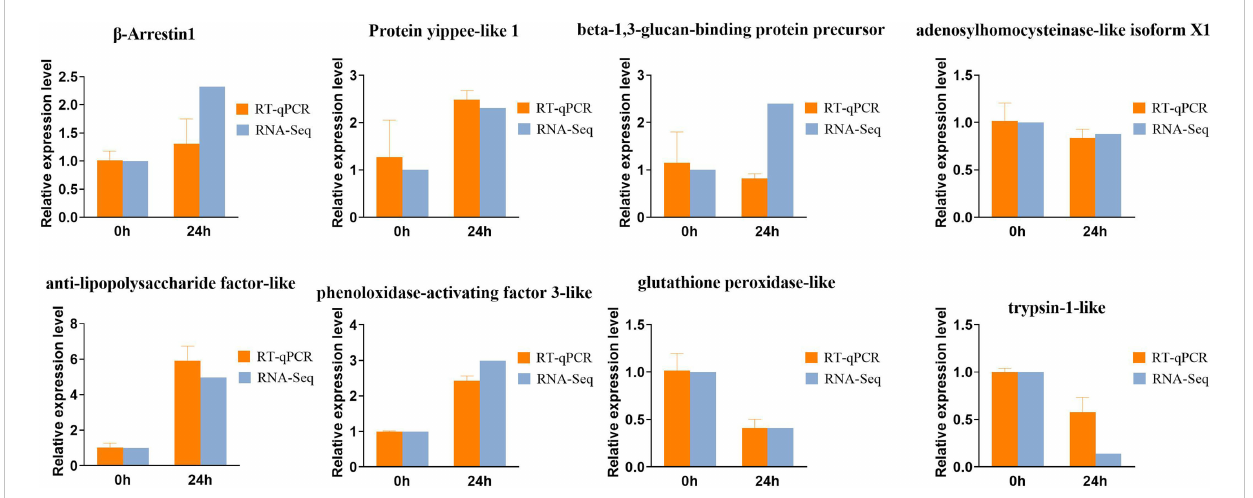
FIGURE 5 Transcripts from RNAseq data were veri fi ed by quantitative real-time PCR (qPCR), where the genes associated on Zoea larvae were beta-Arrestin1, Protein yippee-like 1, beta-1, 3-glucan-binding protein precursor, adenosine homocysteinase-like isoform X1, and on adults were anti- lipopolysaccharide factor-like, phenol oxidase activator 3-like, glutathione peroxidase-like and trypsin-like. The error bars indicate standard error of the mean from biological triplicates. Different letters show signi fi cant different by ANOVA ( p value <